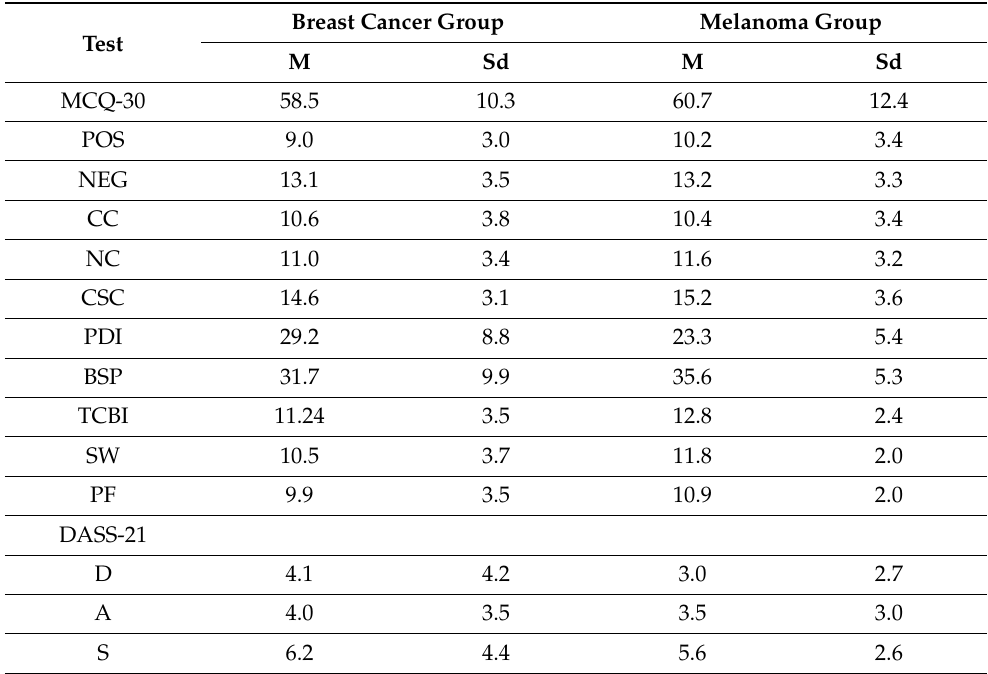
Table 3. The raw score (mean and standard deviations) of participants in the psychological evaluation. Breast Cancer Group Melanoma Group Test M Sd M Sd